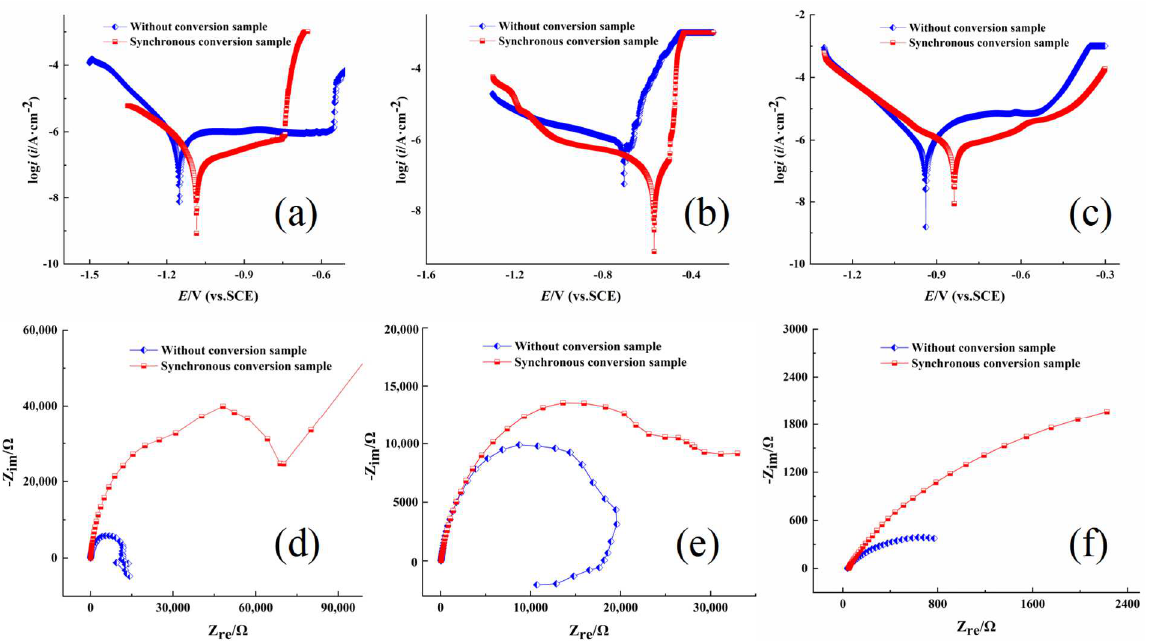
Figure 2. Electrochemical analysis for without and with synchronous chemical conversion coatings of multi − metal samples: ( a ) Polarization curves of AA6061, ( b ) polarization curves of AA7075, ( c ) polarization curves of galvanized steel, ( d ) Nyquist plots of AA6061, ( e ) Nyquist plots of AA7075, ( f ) Nyquist plots of galvanized steel.